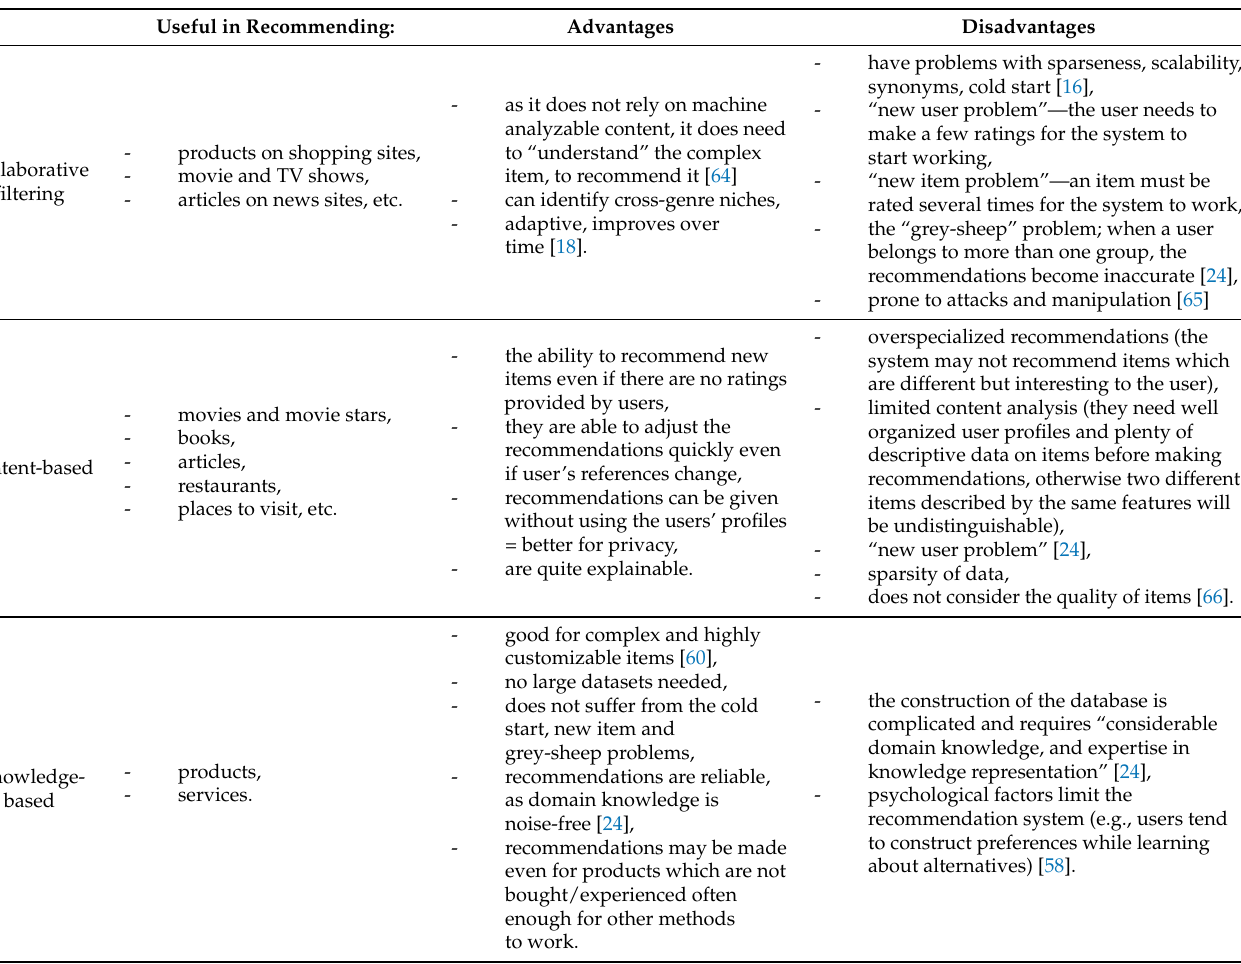
Table 2. The comparison of collaborative filtering, content-based and knowledge-based recommender systems; compiled by the authors based on the subject